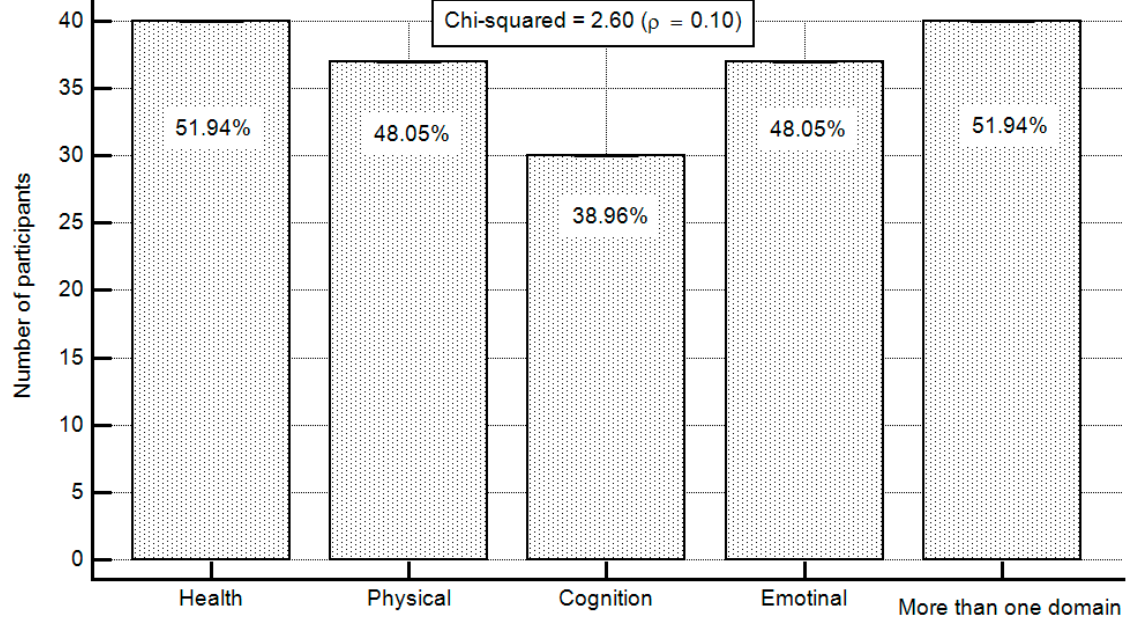
Figure 2. Types of health-related services study participants are interested in receiving information about.